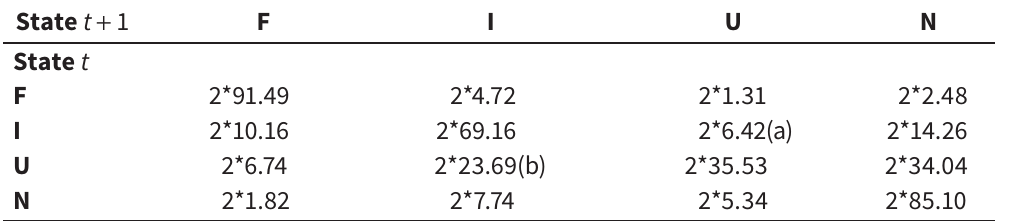
Average quarterly transition probabilities (in%) State t + 1